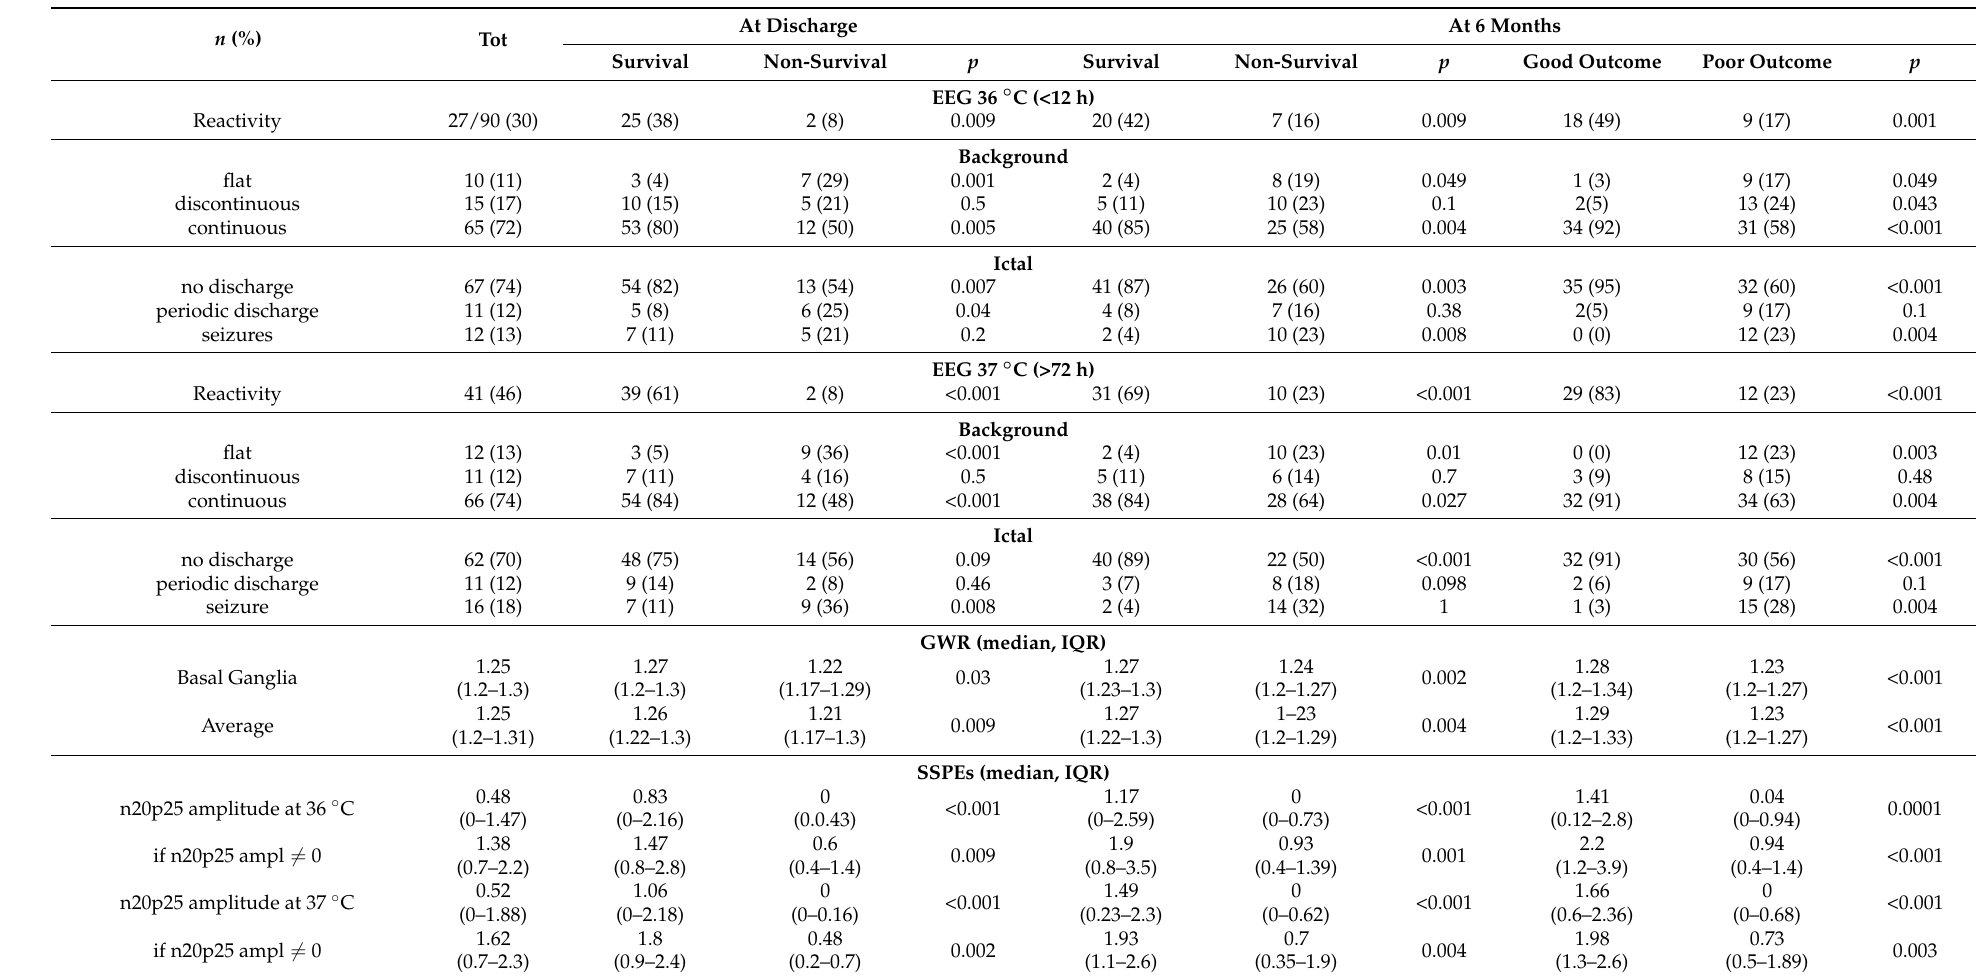
Table 3. Association of GWR, EEG and SSEP features at 36 ◦ C and 37 ◦